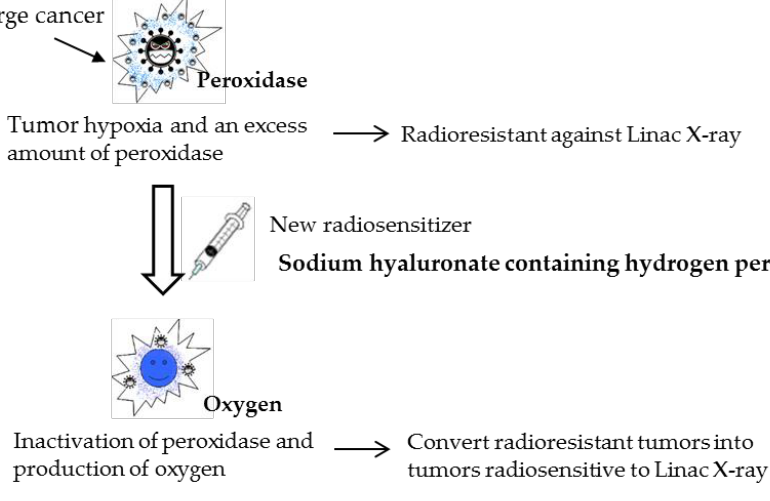
Figure 1. The concept of a new enzyme-targeting radiosensitization treatment (KORTUC II). Using a new radiosensitizer, various radioresistant tumors can be converted into radiosensitive tumors.